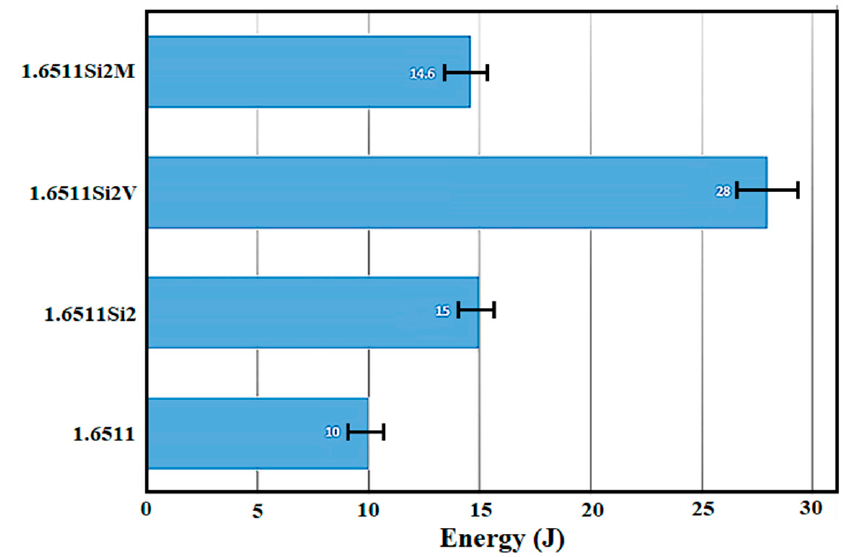
Figure 14. Graph of the energy absorbed during the impact test of the samples .